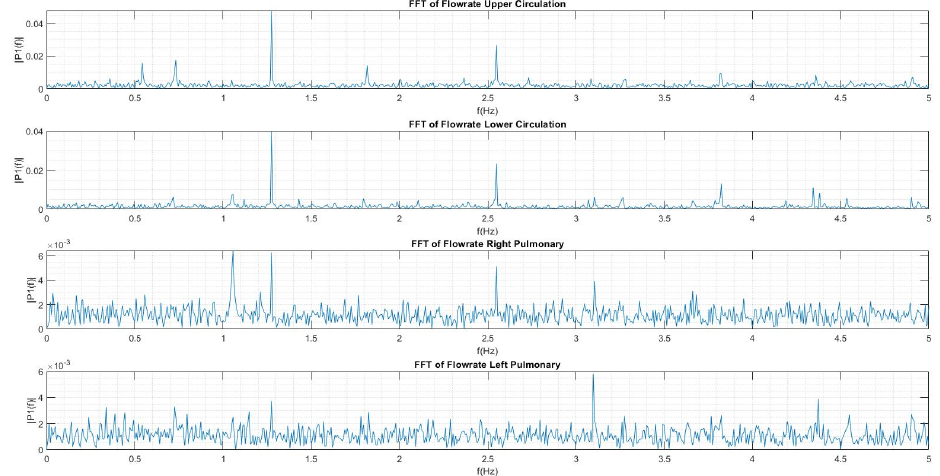
Figure A3. FFT on flow waveform for 3 mm IJS with 30% PVR.